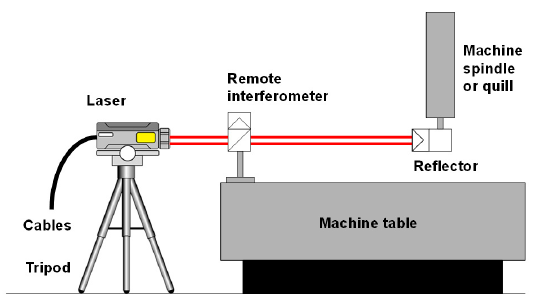
Figure 6. Direct measurement of positioning error through a laser interferometer [67]. (Copyright Renishaw plc. All rights reserved. Image (s) reproduced with the permission of Renishaw.)